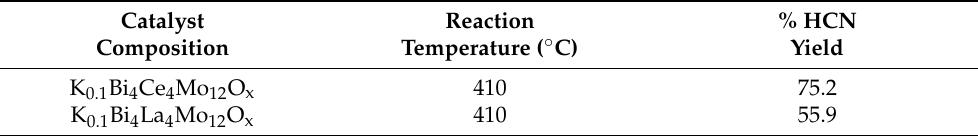
Table 4. Comparison of cerium and lanthanum as promoters of bismuth molybdate for the selective ammoxidation of methanol to HCN